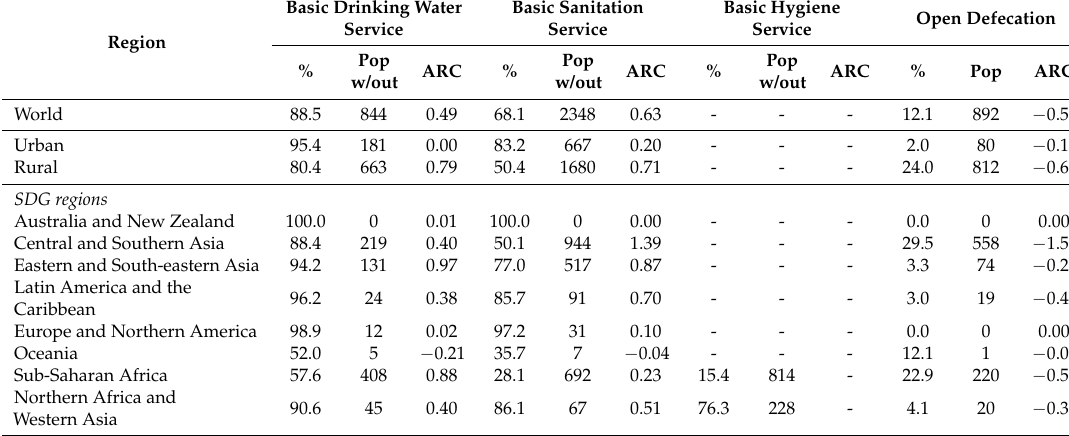
Table 5. Populations using basic services or practising open defecation in 2015 and annual rate of change (2000–2015) globally and by SDG region. Basic Drinking Water Basic Sanitation Basic Hygiene Open Service Service Service Region